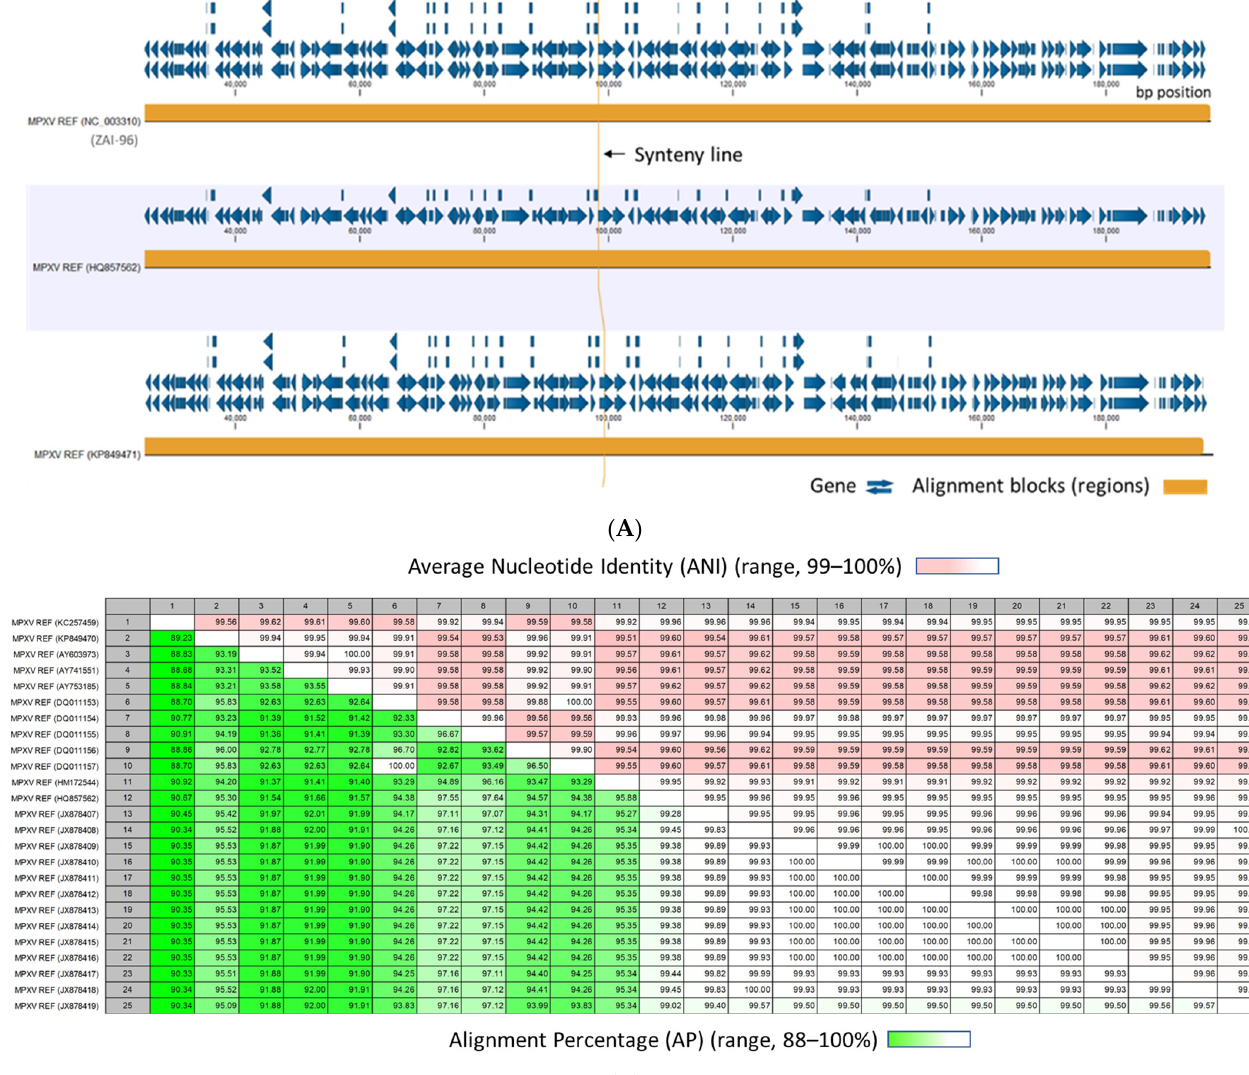
Figure 3. Representative views of the MPXV Whole Genome Alignment (WGA) and Pairwise Comparison Table ( A ) MPXV WGA view shows the alignments between three MPXV genomic sequences. The view of the entire alignment (218 whole MPXV genomes) is shown in Supplementary Video S1. The synteny blocks (conserved genomic regions among strains) and connected line correspond to aligned regions of the genomes (orange rectangle); ( B ) Pairwise comparison table with quantitative measures of similarity between MPXV genomes. Lower comparison matrix tabulates the Alignment Percentage (AP) or average alignment percentage between two MPXV genomes (range, 88–100%). Upper comparison matrix tabulates the Average Nucleotide Identity (ANI) or the percentage of exact nucleotide matches of the aligned regions (range, 99–100%). The lightest shades of green or pink corresponds to the highest sequence similarity